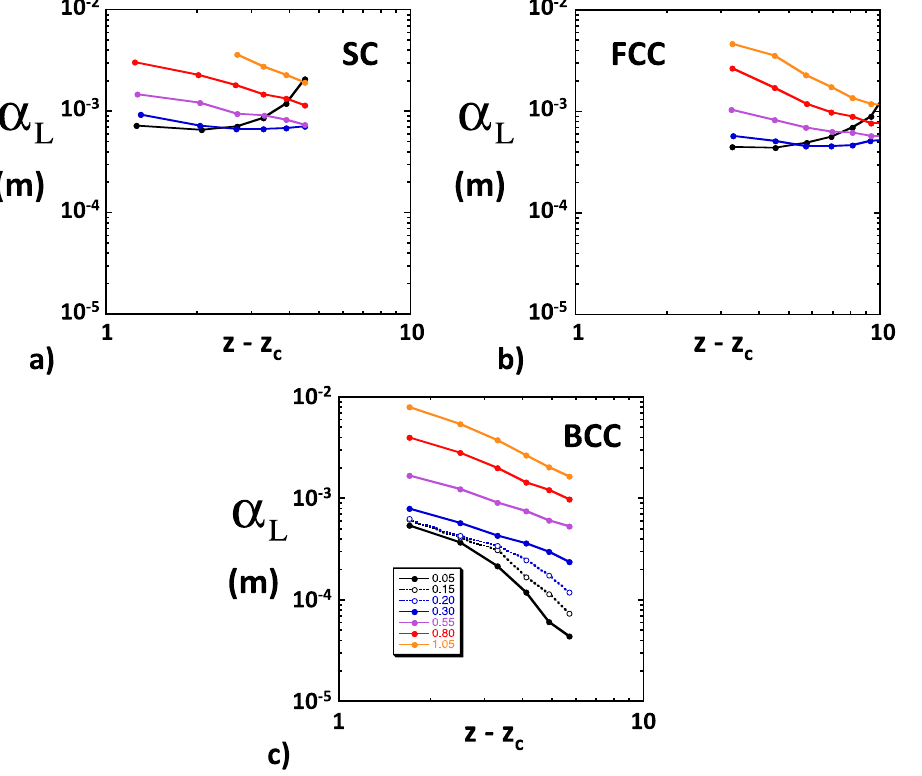
Figure 1. Simulated longitudinal dispersivity as a function Z − Z c . These simulations were run in ( a ) SC, ( b ) FCC and ( c ) BCC network realizations. In these examples, we used 10000 particles, U = 10 − 4 ms − 1 , R = 40 × 10 − 6 m, l = 300 × 10 − 6 m and 7 different coefficients of variations CV , namely, 0.05 (solid black), 0.15 (dotted black), 0.20 (dotted blue), 0.30 (solid blue), 0.55 (purple), 0.80 (red) and 1.05